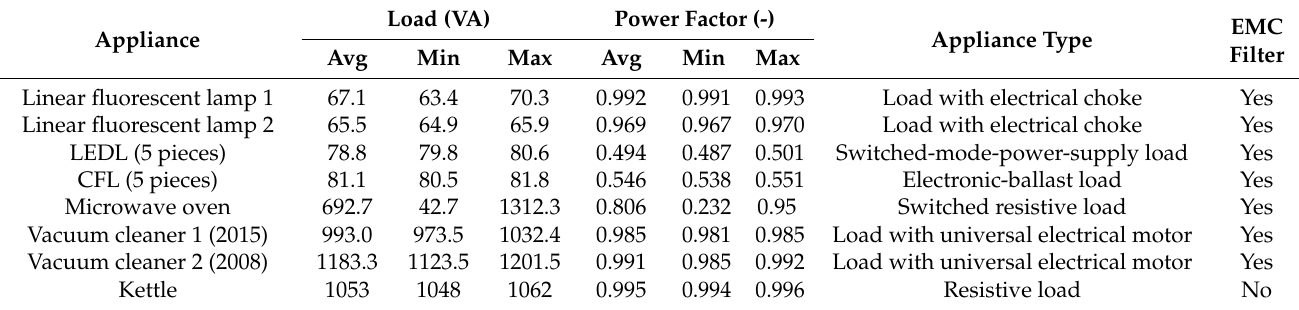
Table 2. Various parameters of the measured appliance